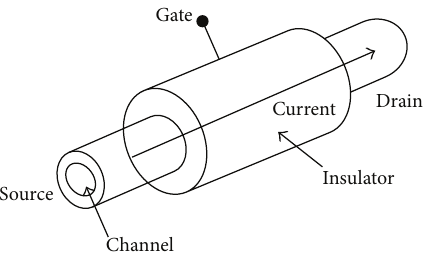
Figure 1: Structure of